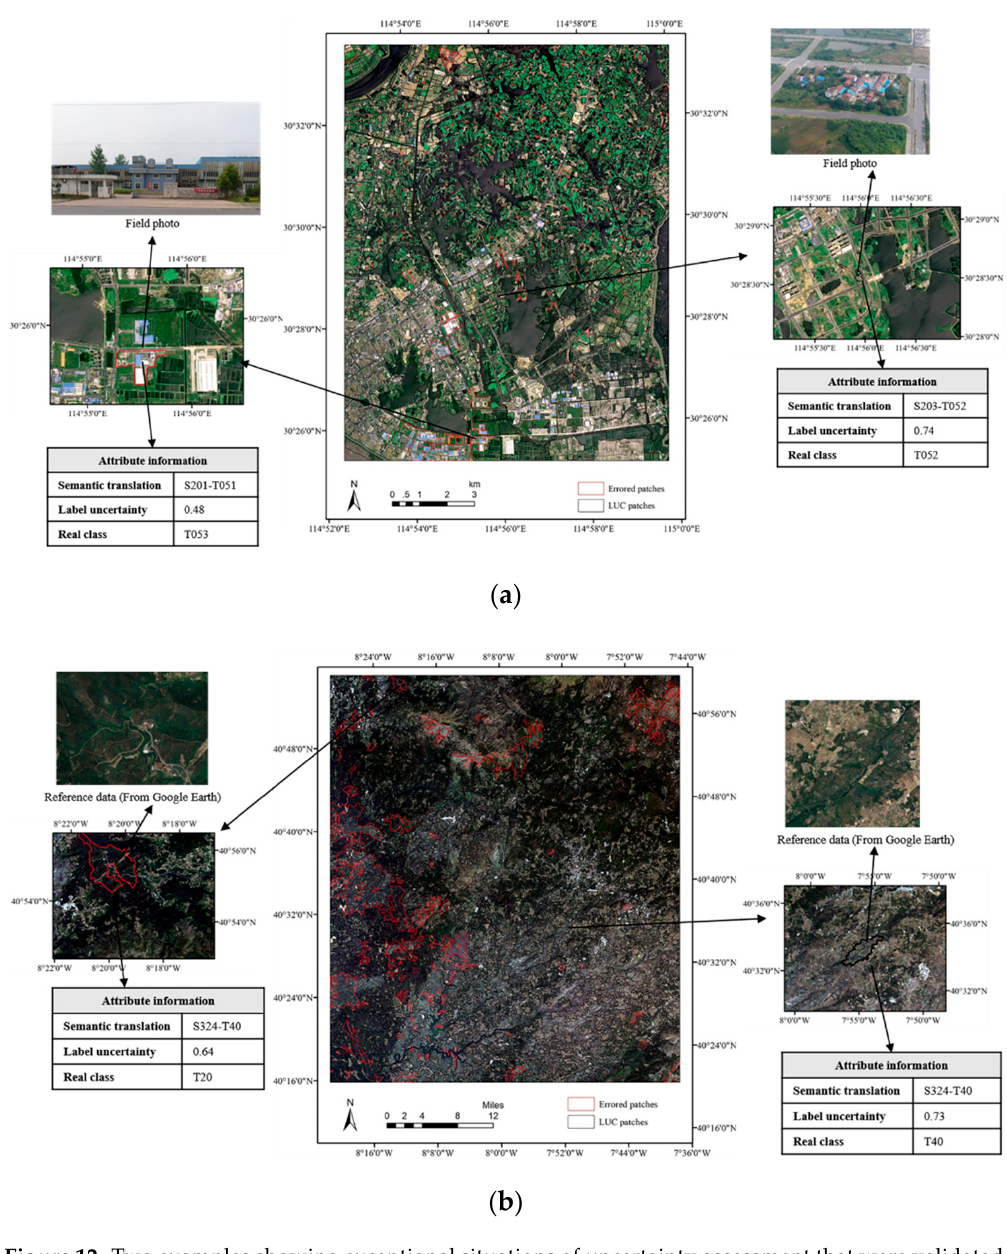
Figure 12. Two examples showing exceptional situations of uncertainty assessment that were validated through field surveys and auxiliary data: ( a ) example from Dataset 1; ( b ) example from Dataset 3.